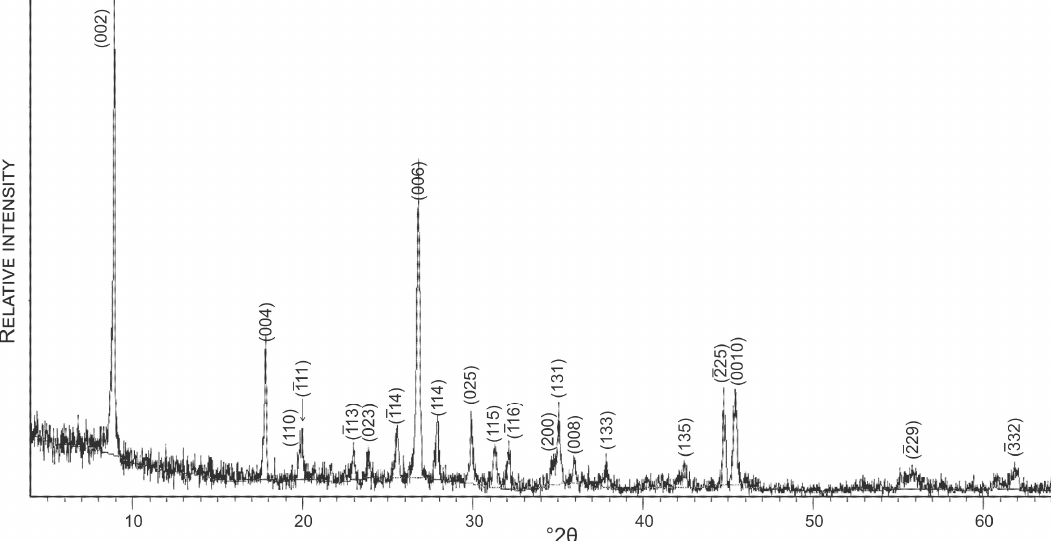
Figure 8. 40 Ar/ 39 Ar apparent age spectra of the coarse-grained muscovite sample. Laser energy increases from left to right. Vertical width of bars represents the 2 σ error and includes the error of the J-value. Steps 4–10 are used for calculation of the plateau age.